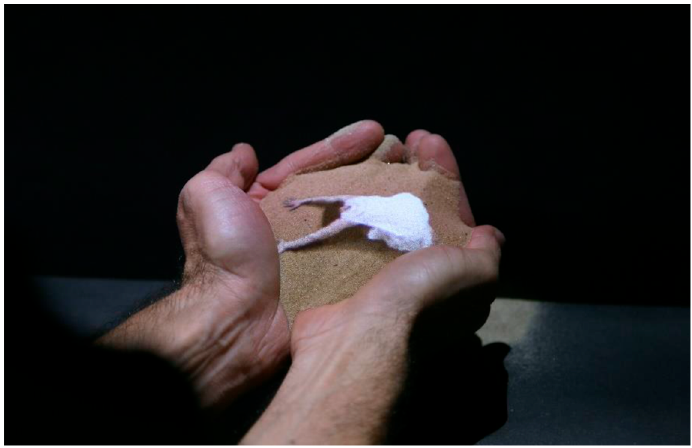
Figure 10. Visitor scooping up sand with a projected image.